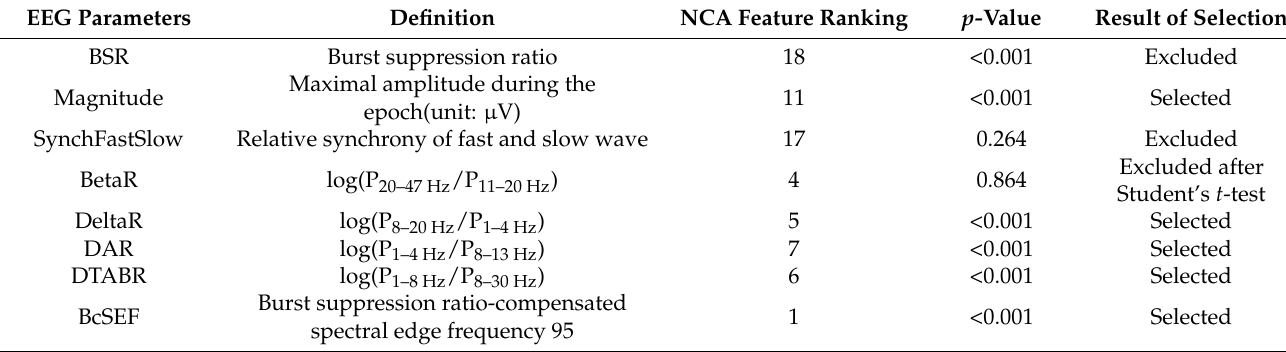
Table 3. The result of feature selection process among 20 EEG